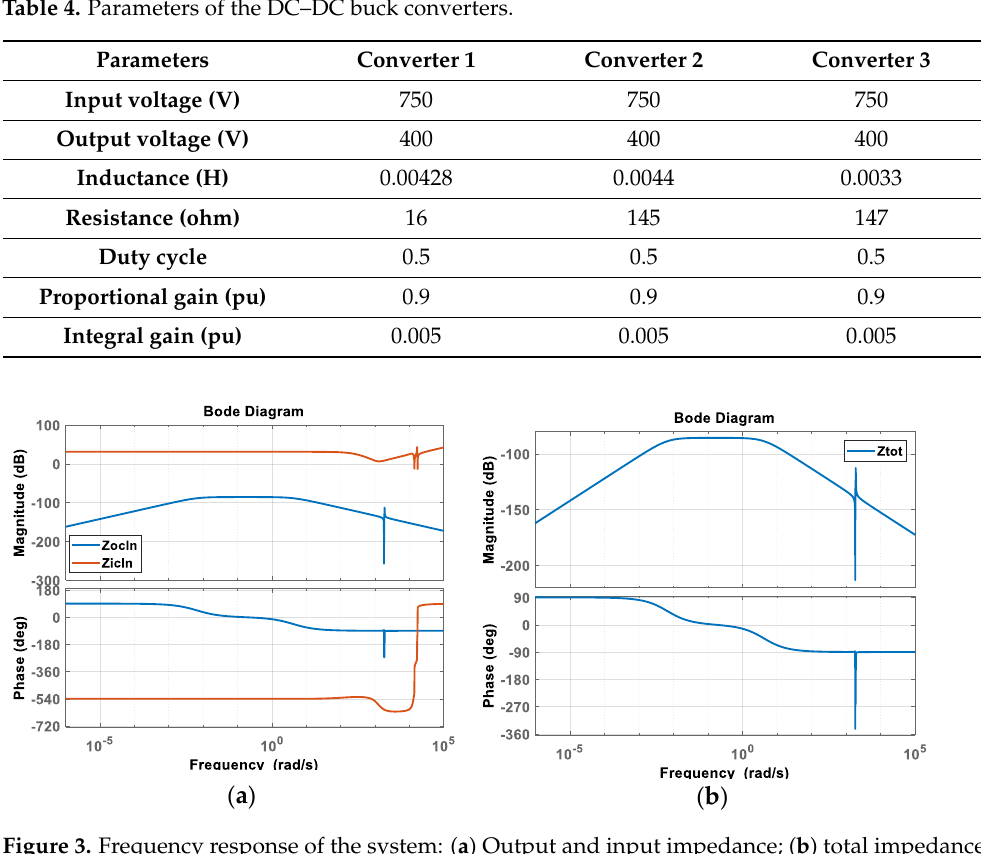
Table 3. Parameters of the DC – DC boost converters.